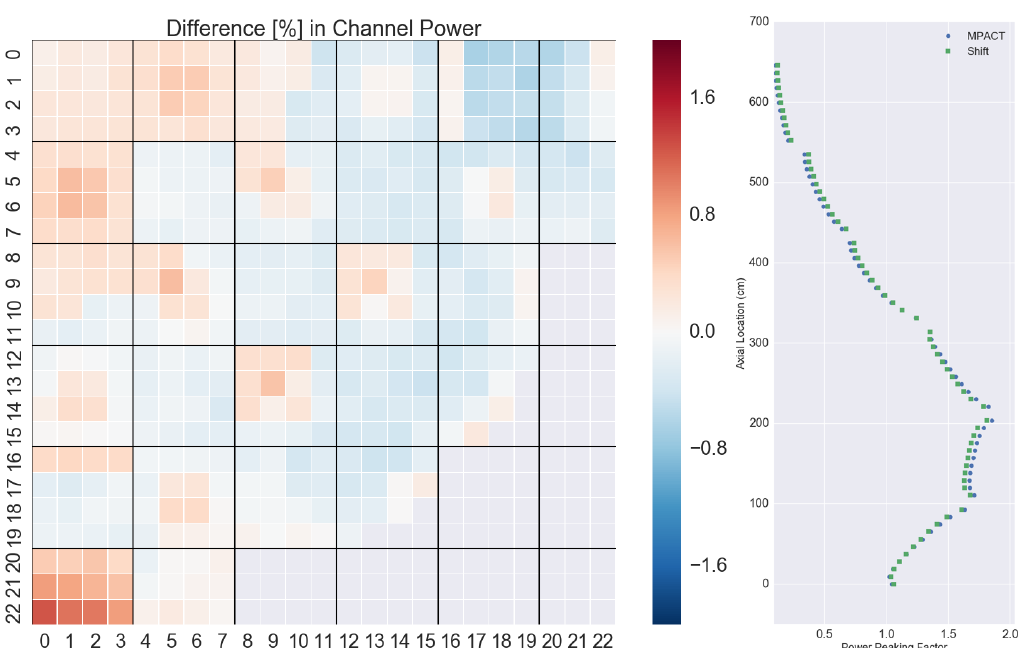
Figure 5. Radial and axial power distribution comparison for CRM-7 at 50% insertion